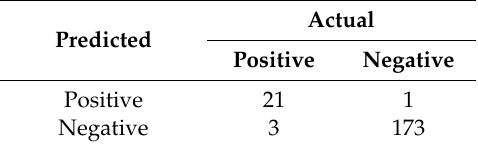
Table 5. Confusion matrix for model Fcarb in an experiment.